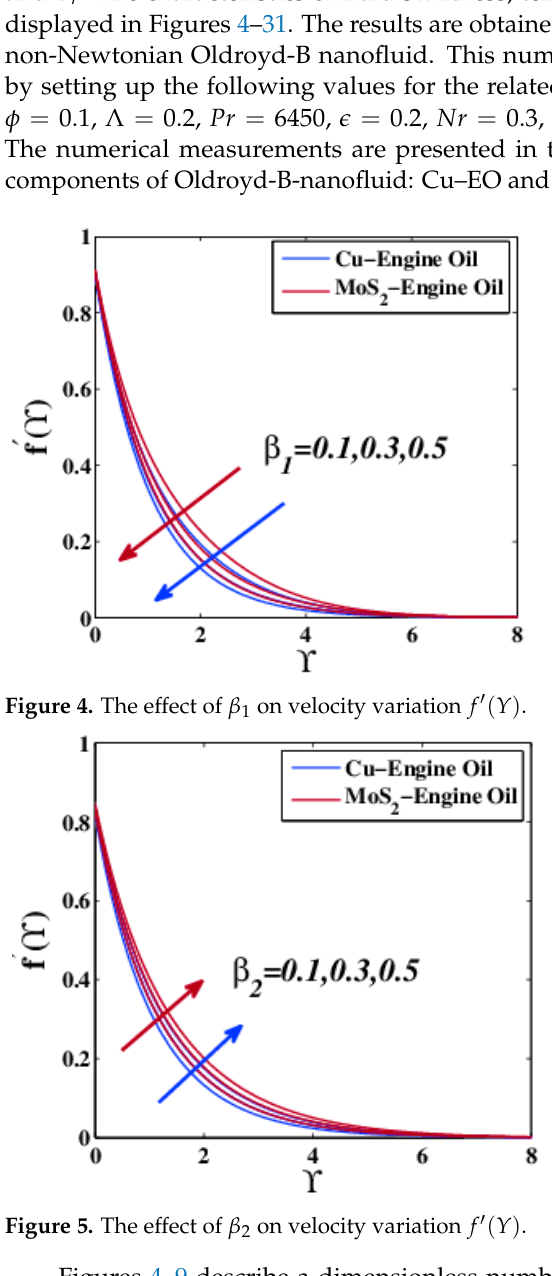
8 of 26 Table 3. Comparison of −𝜃 (cid:4593) (0) with various values of 𝑃𝑟 when 𝜙 = 0 , 𝜖 = 0 , Λ = 0 , 𝑁𝑟 = 0 , 𝑆 = 0 , and 𝐵 (cid:3098) = 0 . 𝑷𝒓 Ref. [48]